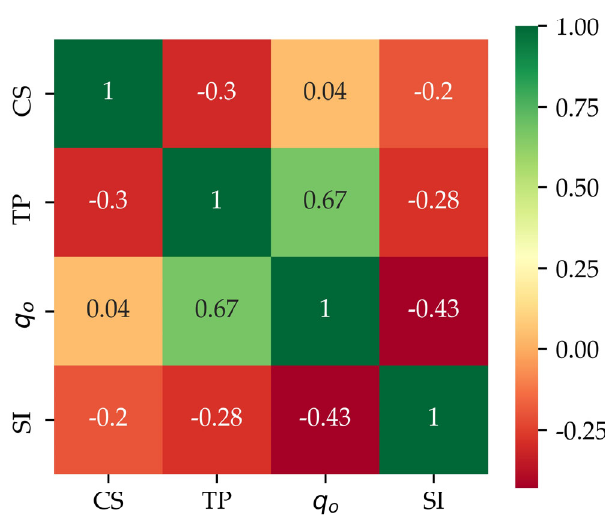
Figure 4. Heatmap of Pearson correlation coefficients of various variables. Table 1. Statistical property of input